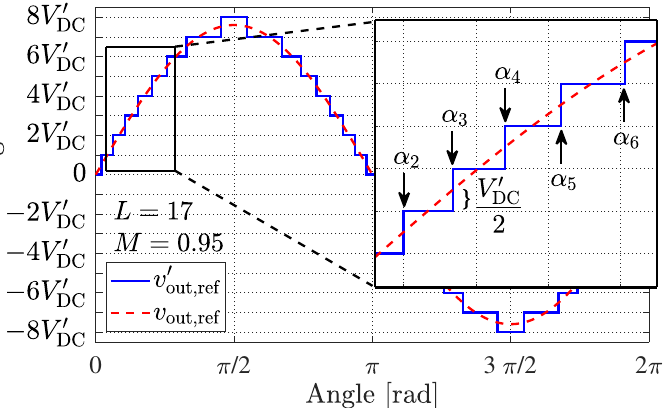
Figure 2. Desired, modulated reference voltage waveform v (cid:48) 17-level converter and a modulation index M =